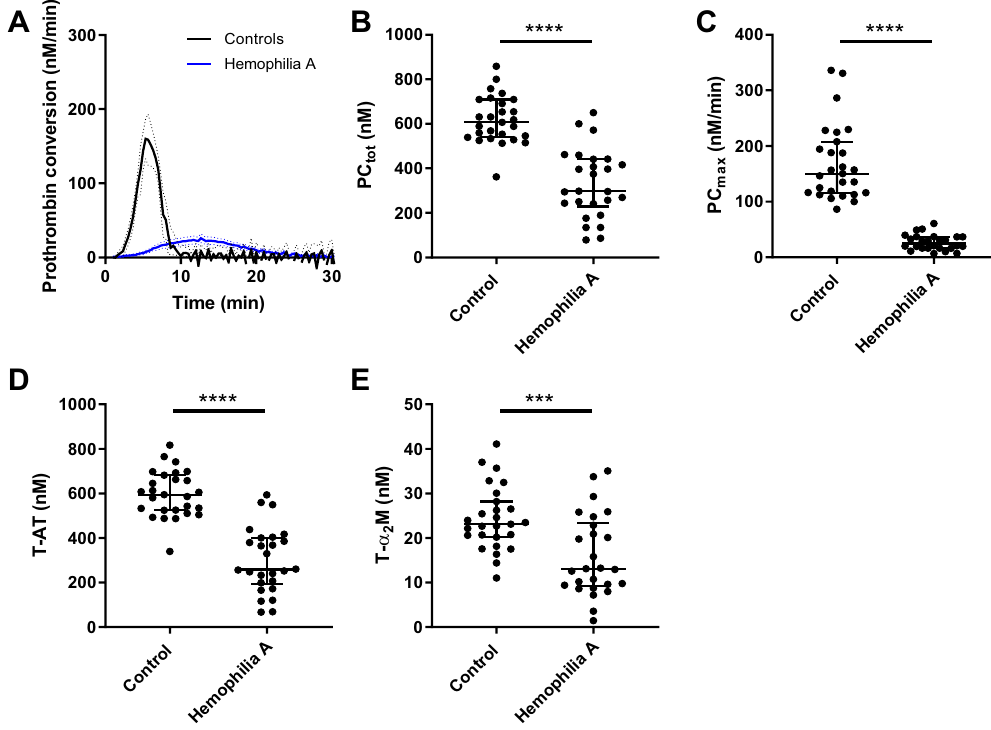
Figure 3. Prothrombin conversion in haemophilia A triggered with 1 pM tissue factor. Prothrombin conversion curves were determined from TG curves measured at 1 pM TF. ( A ) Average prothrombin conversion curves for the patient and control group. Individual TG curves were quantified by the total prothrombin conversion (PC tot , B ), maximum prothrombin conversion rate (PC max , C ), thrombin-antithrombin complex formation (T-AT, D ), and thrombin-α 2 macroglobulin complex formation (T-α 2 M) ( E ). Prothrombin conversion curves are depicted as the mean curve (continuous line) ± the 95% confidence interval (dotted lines) and the parameter values are shown as the individual values with the median ± interquartile range. Statistical significance according to the Mann Whitney test is indicated as *** for a p -value < 0.001, **** for a p -value <